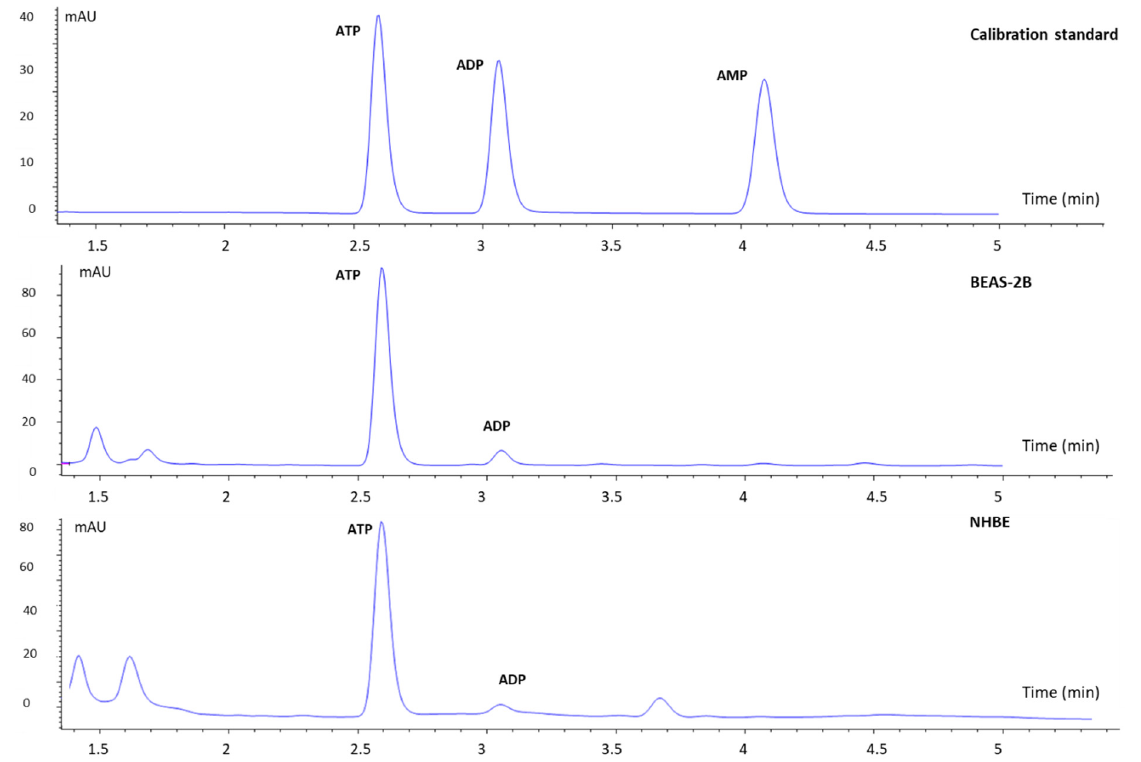
Figure 1. Representative overlaid HPLC chromatograms of calibration standard (X), BEAS-2B cells sample, differentiated NHBE cells sample. Poroshell 120 EC-C18 (3 × 150 mm, 2.7 µ m), 20 ◦ C, 50 mM of potassium hydrogen phosphate (pH 6.80), 0.6 mL/min, 254 nm.